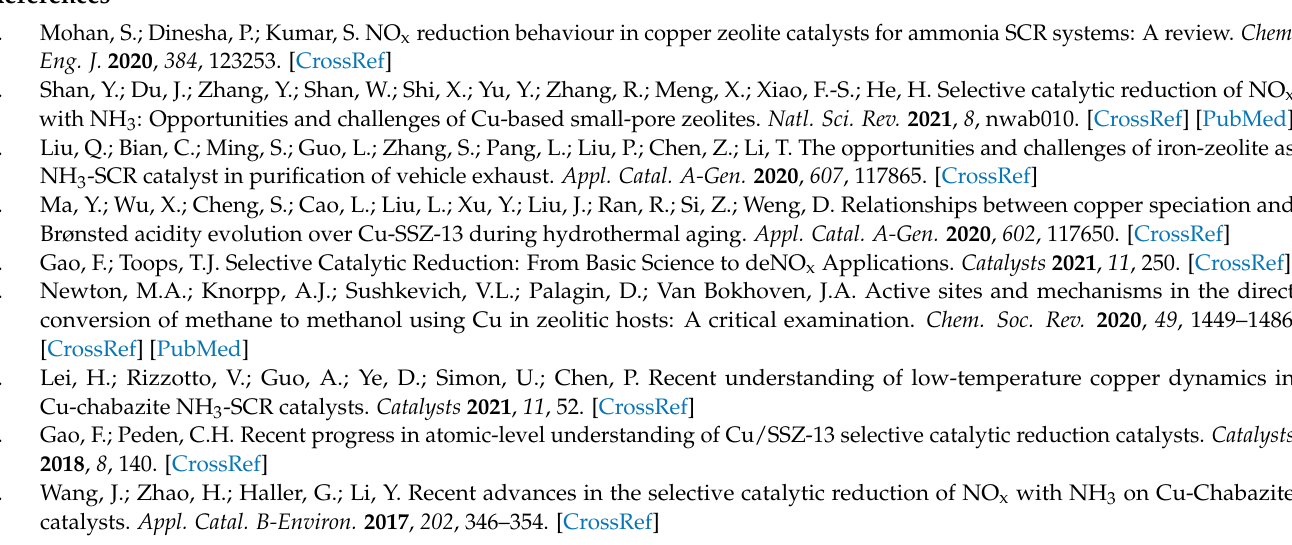
Table S1: The intensity ratio of peak “*” and peak “ˆ” in 27 Al solid state NMR